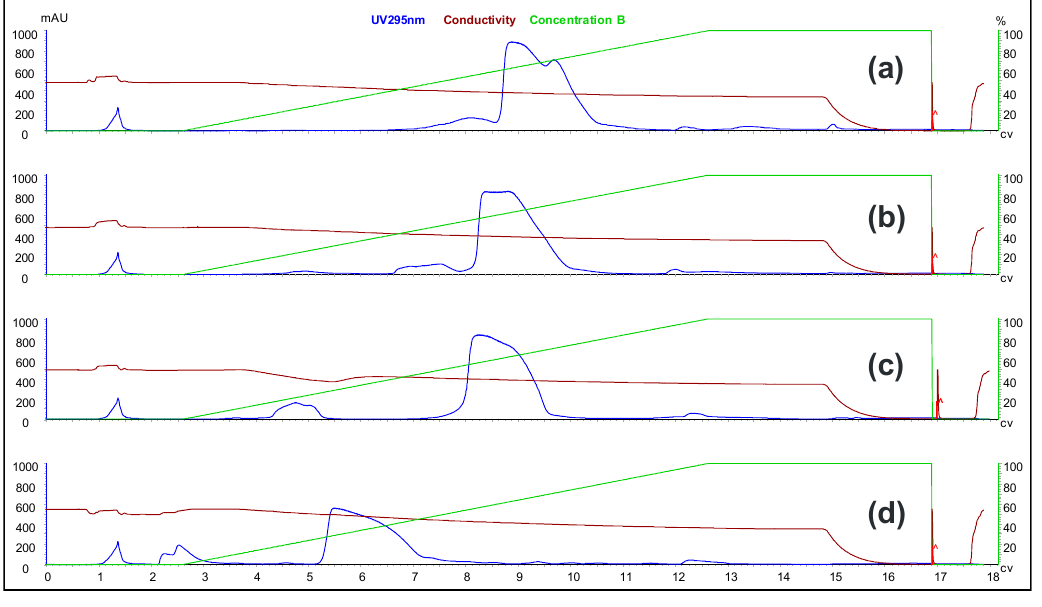
Figure 4. RP-HPLC purification of crude GalNAc-conjugated oligonucleotide. Mobile Phase A is 200 mM NaOAc in 20% MeOH. Mobile Phase B is 200 mM NaOAc in 60% MeOH. Both mobile phases adjusted to: ( a ) pH 7, ( b ) pH 10, ( c ) pH 11, and ( d ) pH 12.